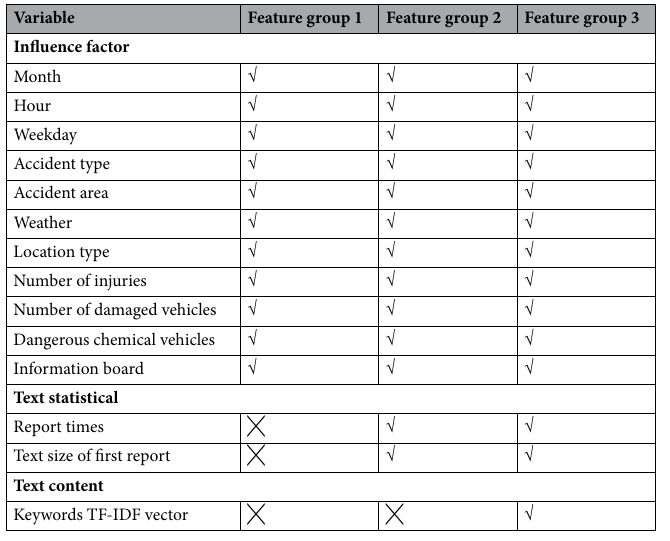
Table 1. Feature group.